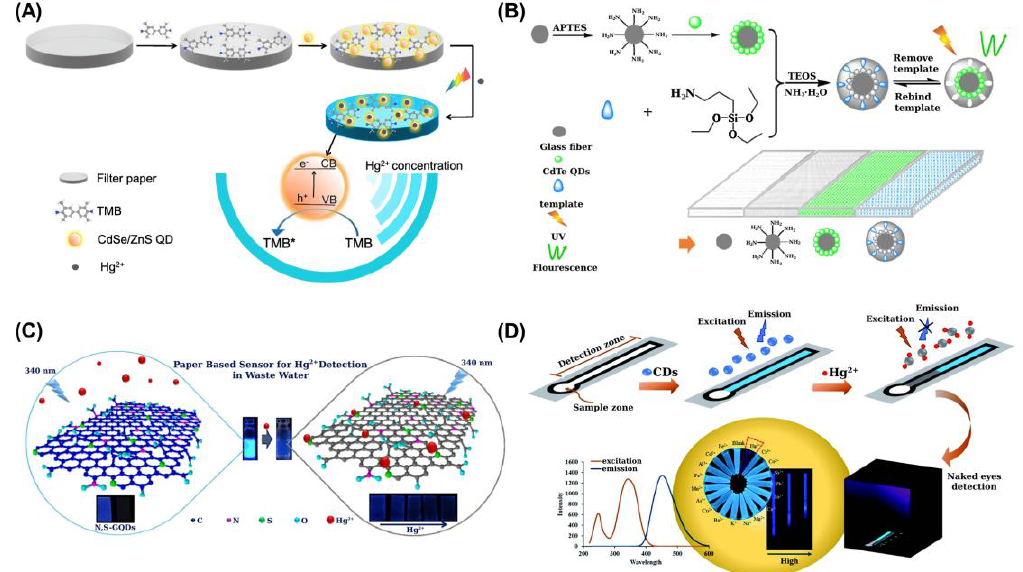
Figure 6. ( A ) Scheme of PAD based on the enhanced photocatalytic activity displayed by CdSe/ZnS QDs on TMB oxidation under visible light in the presence of Hg(II) [78]; ( B ) preparation of an ion-imprinted polymer and grafting onto glass fiber paper to build a 3D origami μ -PAD (Paper@QDs@IIP) [80]; ( C ) scheme showing the detection of Hg(II) based on turn-off fluorescence of N,S-GQDs; the N atoms enhance the fluorescence quantum yield while S atoms serve as the active sites for Hg(II) coordination [81]; ( D ) distance-based micro-PAD for the detection of Hg(II) using nitrogen-doped CDs as fluorescent probes [85]. Figure 6A-D is reproduced with permission of Elsevier [78,80,81] and the Royal Society of Chemistry